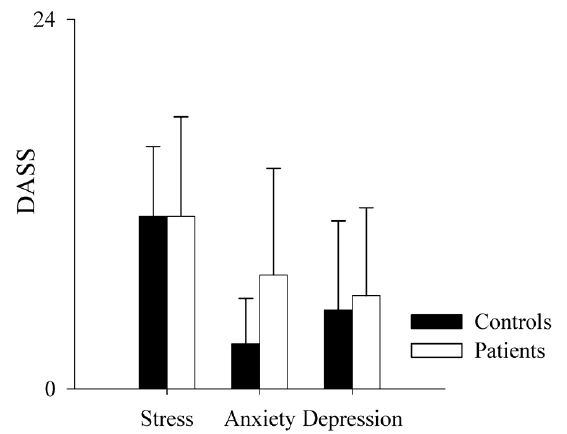
Figure 7. Comparison of the DASS scale sub-scores in healthy controls and PAH patients. The bar graphs show the stress, anxiety and depression subscales of the Depression, Anxiety and Stress Scale (DASS) in healthy controls (black bars) and PAH patients (white bars). Results are presented as mean ± standard deviation. status and ECG-derived parameters at baseline (Table 2) and during MIST (Table 3) did not reveal any correlation. Table 2. Results of the correlation analysis between the ECG-derived parameters and performance and psychological variables in patients and controls at